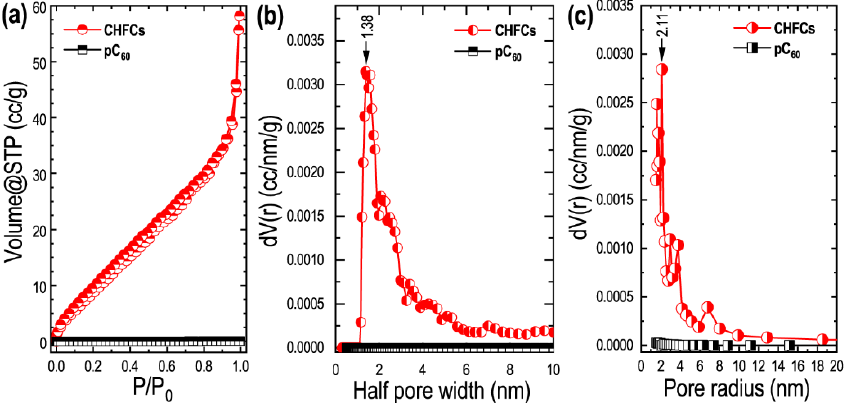
Figure 5. ( a ) Nitrogen sorption isotherms of CHFCs. Pore size distribution profiles obtained from ( b ) DFT and ( c ) BJH method.